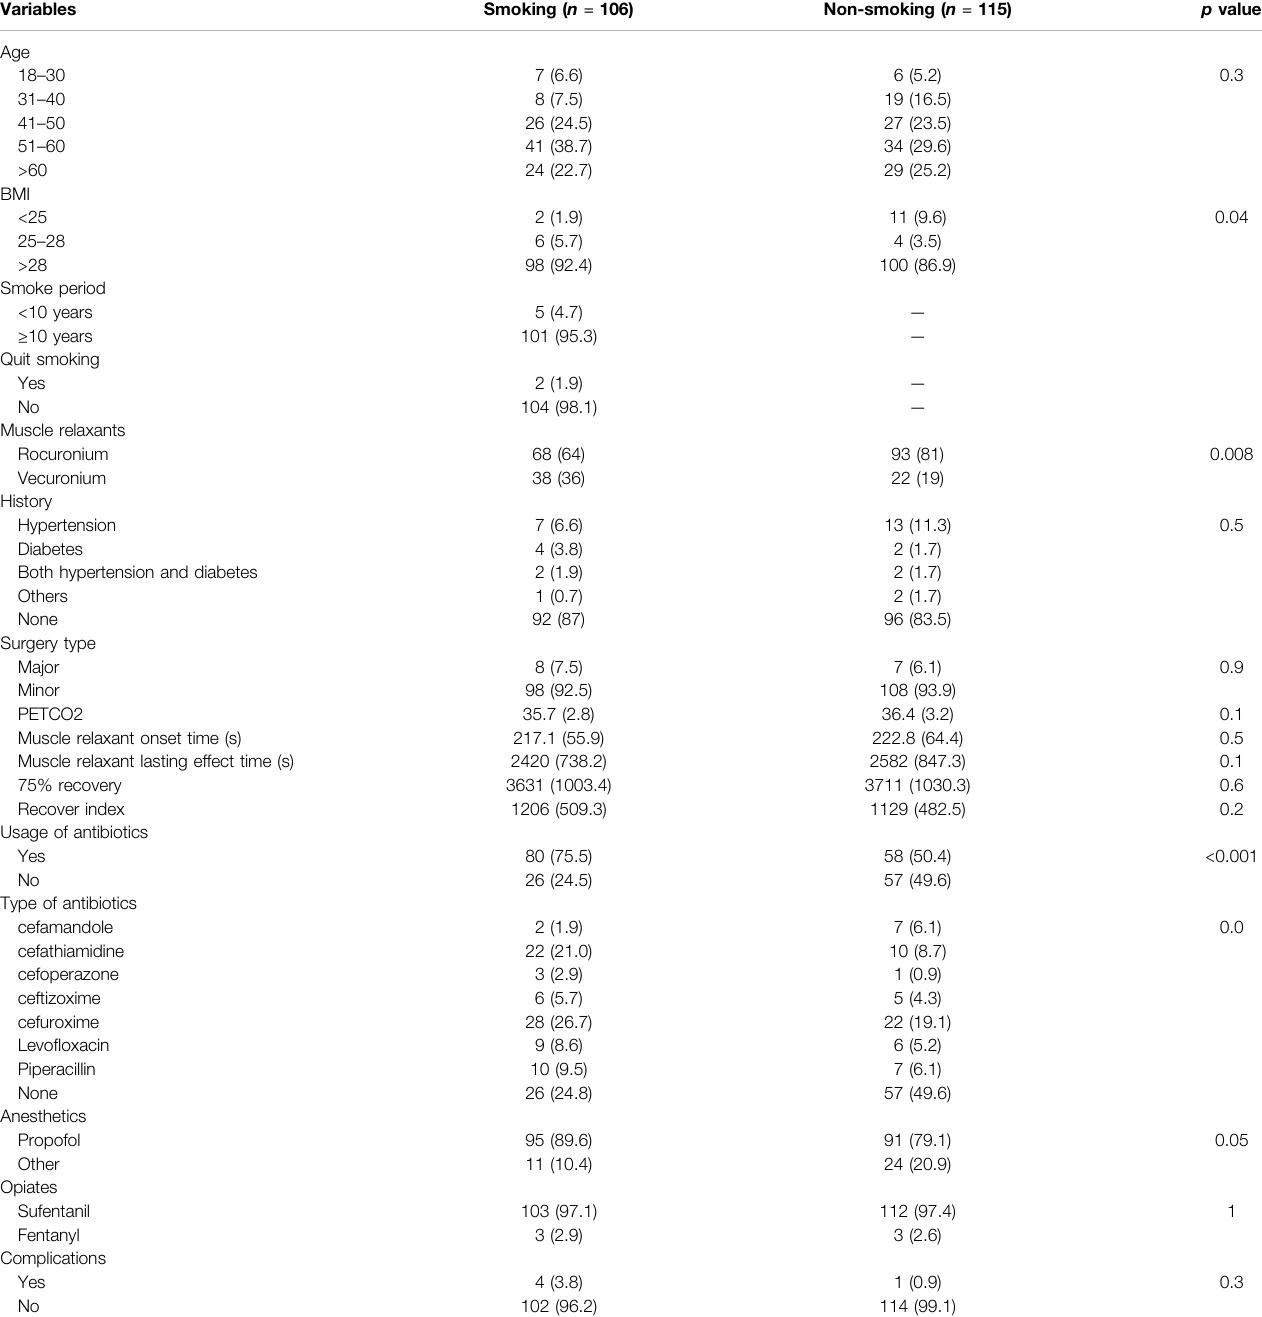
TABLE 1 | Characteristics of included